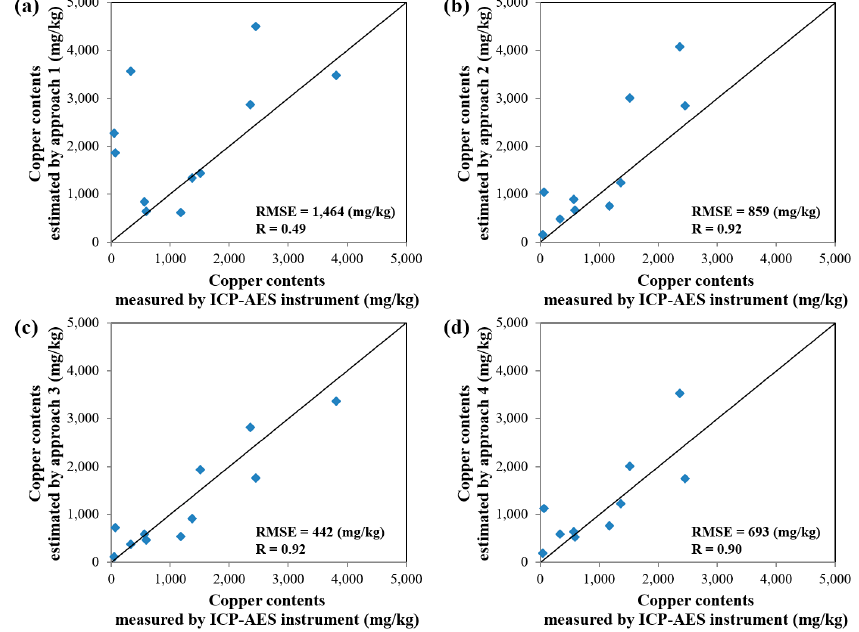
Figure 9. Plot showing the correlation of ICP–AES analysis data and estimated values of copper content in soil contamination maps generated by approaches: ( a ) 1; ( b ) 2; ( c ) 3; and ( d ) 4.